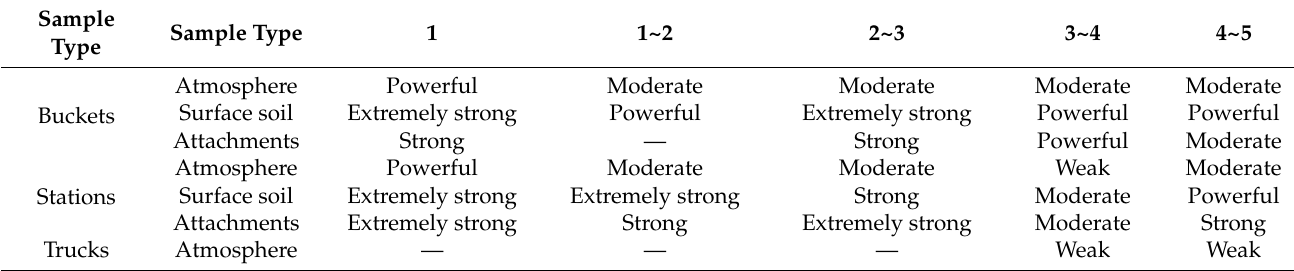
Table 8. Potential ecological risk degrees of the different sample